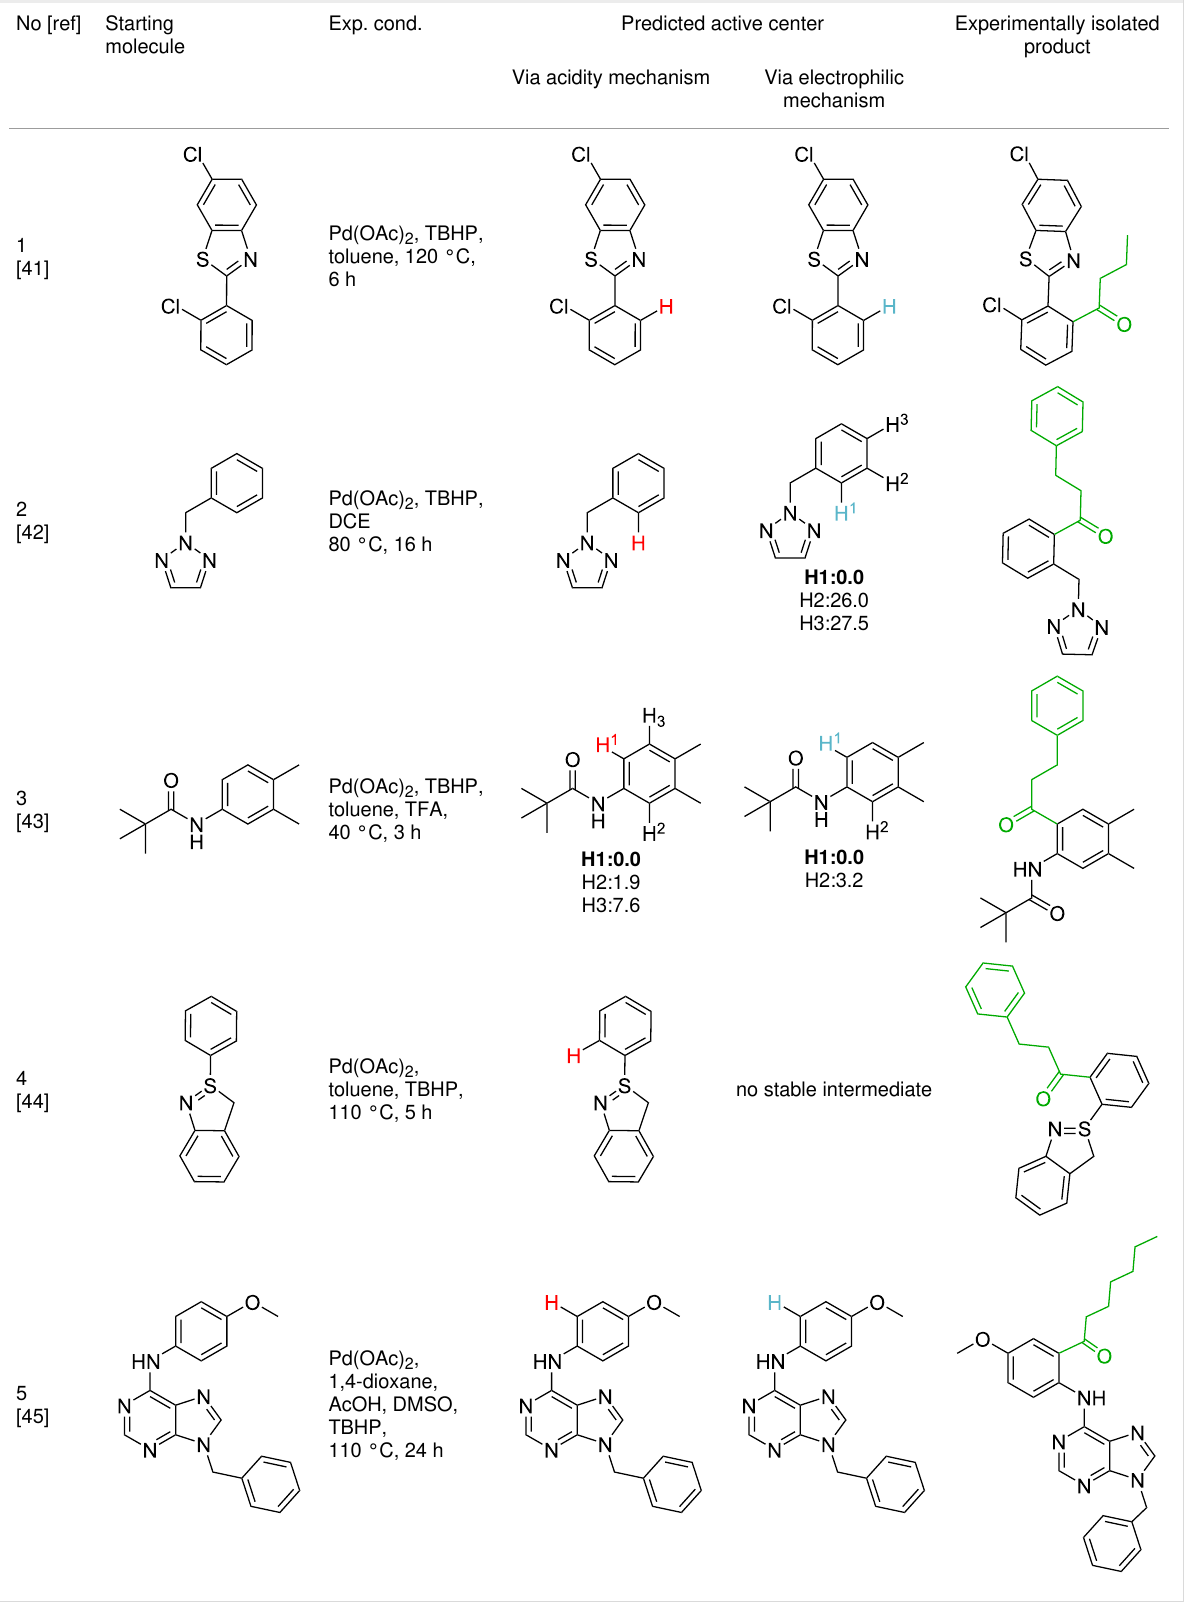
No [ref] Starting